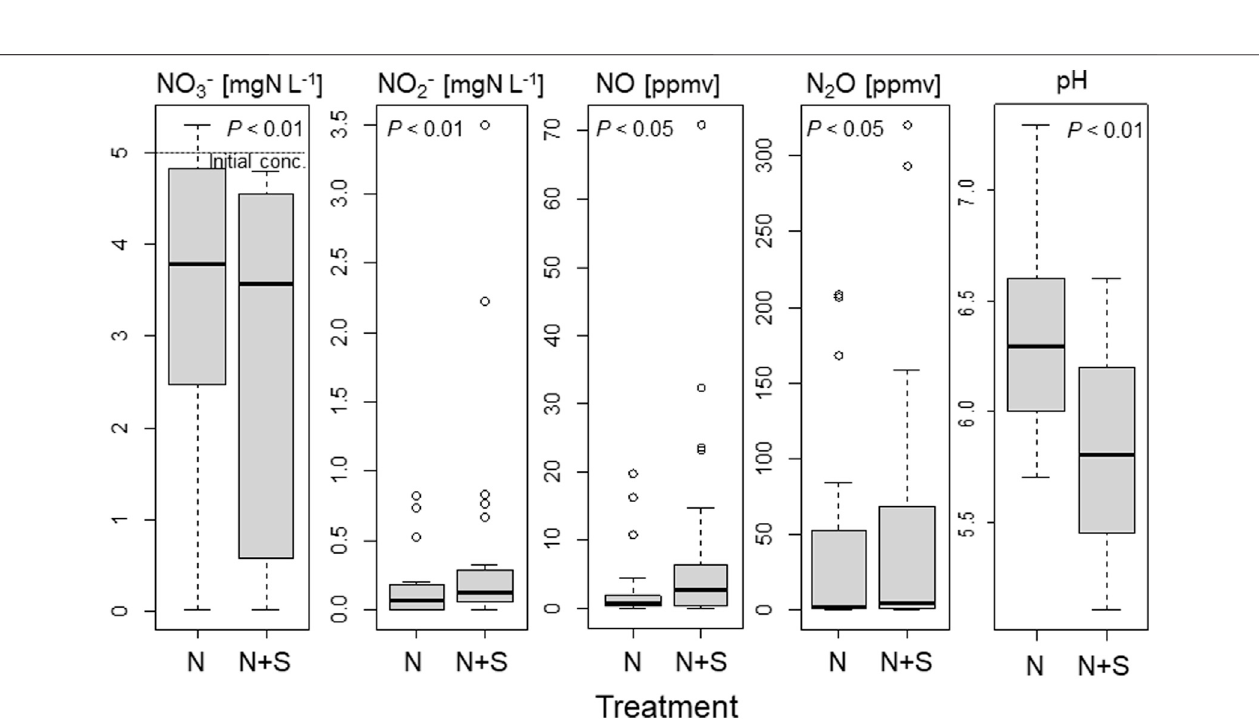
FIGURE 6 | Comparisons of NO 3 − , NO 2 − , NO, and N 2 O concentrations and pH between treatments in the short-term incubation experiment using soils of streambank II. Thick line indicates median value, rectangle 25 – 75% of values. N, KNO 3 solution; N + S, KNO 3 , and Na 2 S 2 O 3 solution.